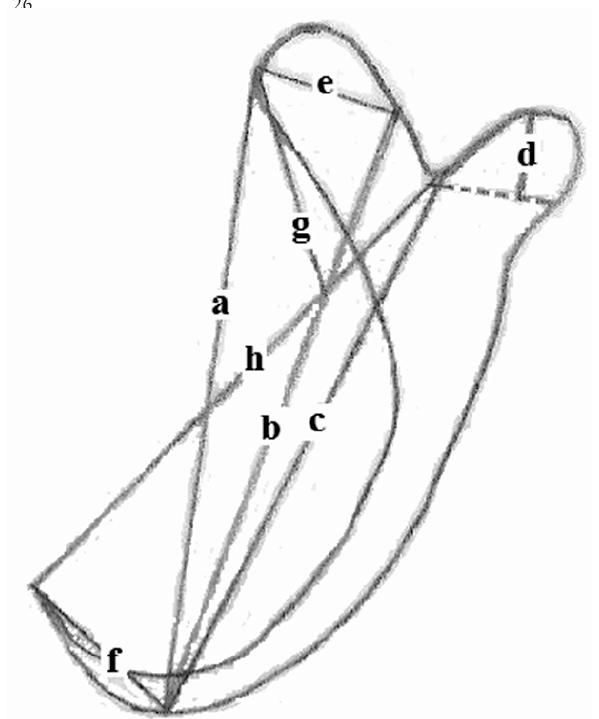
Fig. 2. Measurements of the ancors of Dactylogyrus fraternus ; (a) overall length; (b) length of the anchors without foldable part of the internal process; (c) length of the base; (d) length of the external process; (e) length of the foldable part of the internal process; (f ) length of the internal process; (g) length of the fold- able part of the internal process; (h) width of the